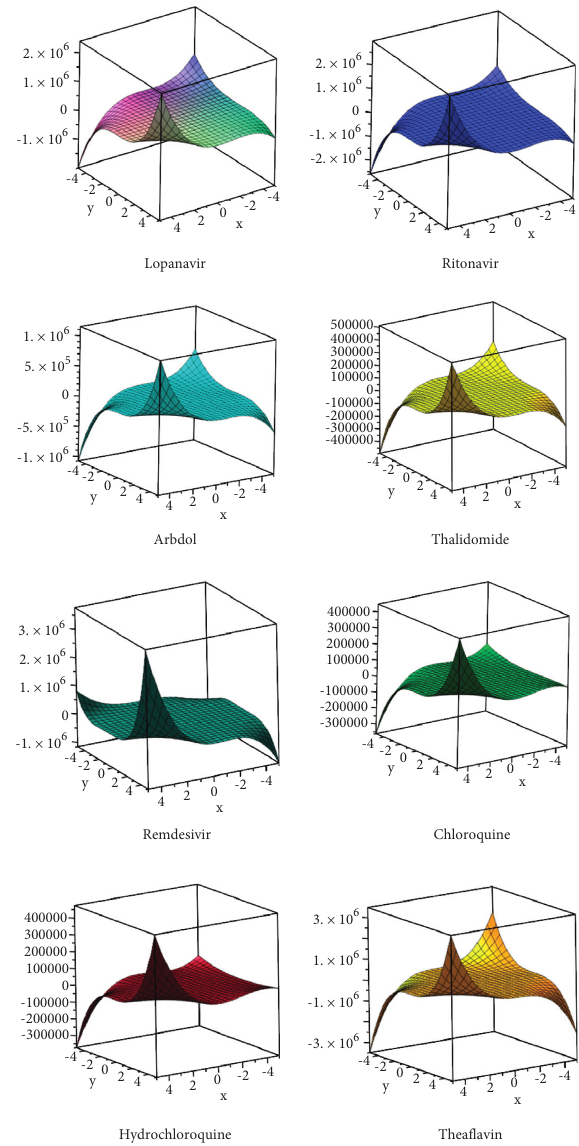
Figure 1: Plot of CoM-polynomials for various antiviral